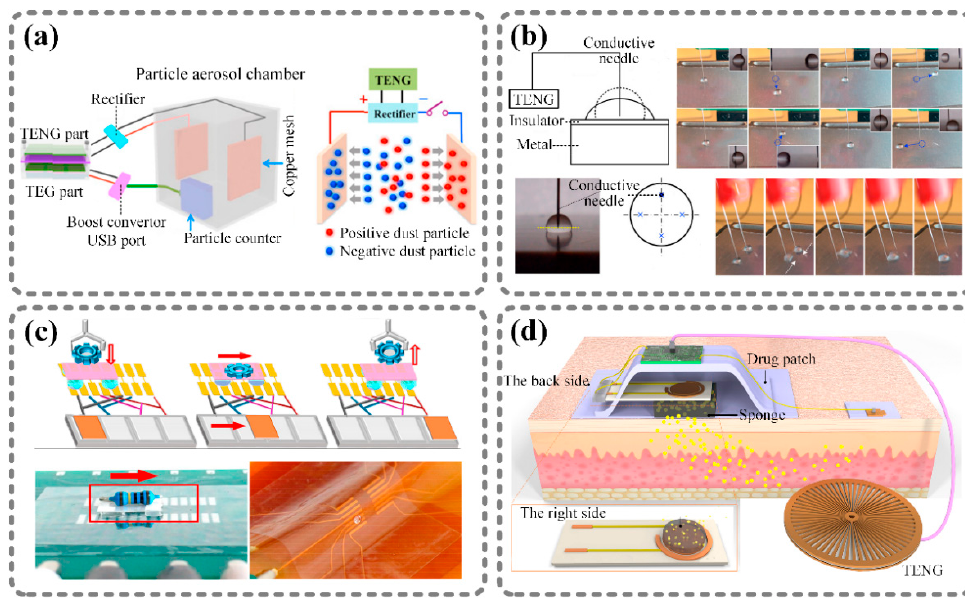
Figure 3. Direct control of solid particles and liquid droplets by nanogenerators. ( a ) Gas purification system based on a TENG [60]. ( b ) TENG-based liquid droplet control device: control of liquid droplets with a TENG [61]. ( c ) Self-powered transport system based on microfluids: PVDF pallet with four droplets can be manipulated to move on aluminum foils [62]. ( d ) Electric-stimulated porous polypyrrole film: self-powered drug delivery system [63]. Reproduced with permission from Elsevier [60,61,63] and American Chemical Society [62].